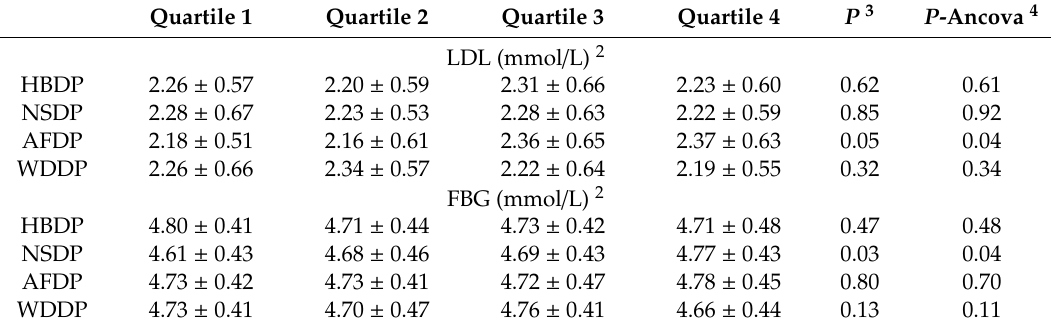
Table 6. Energy intake, physical activity, and sleep duration compared by genotypes in boys.